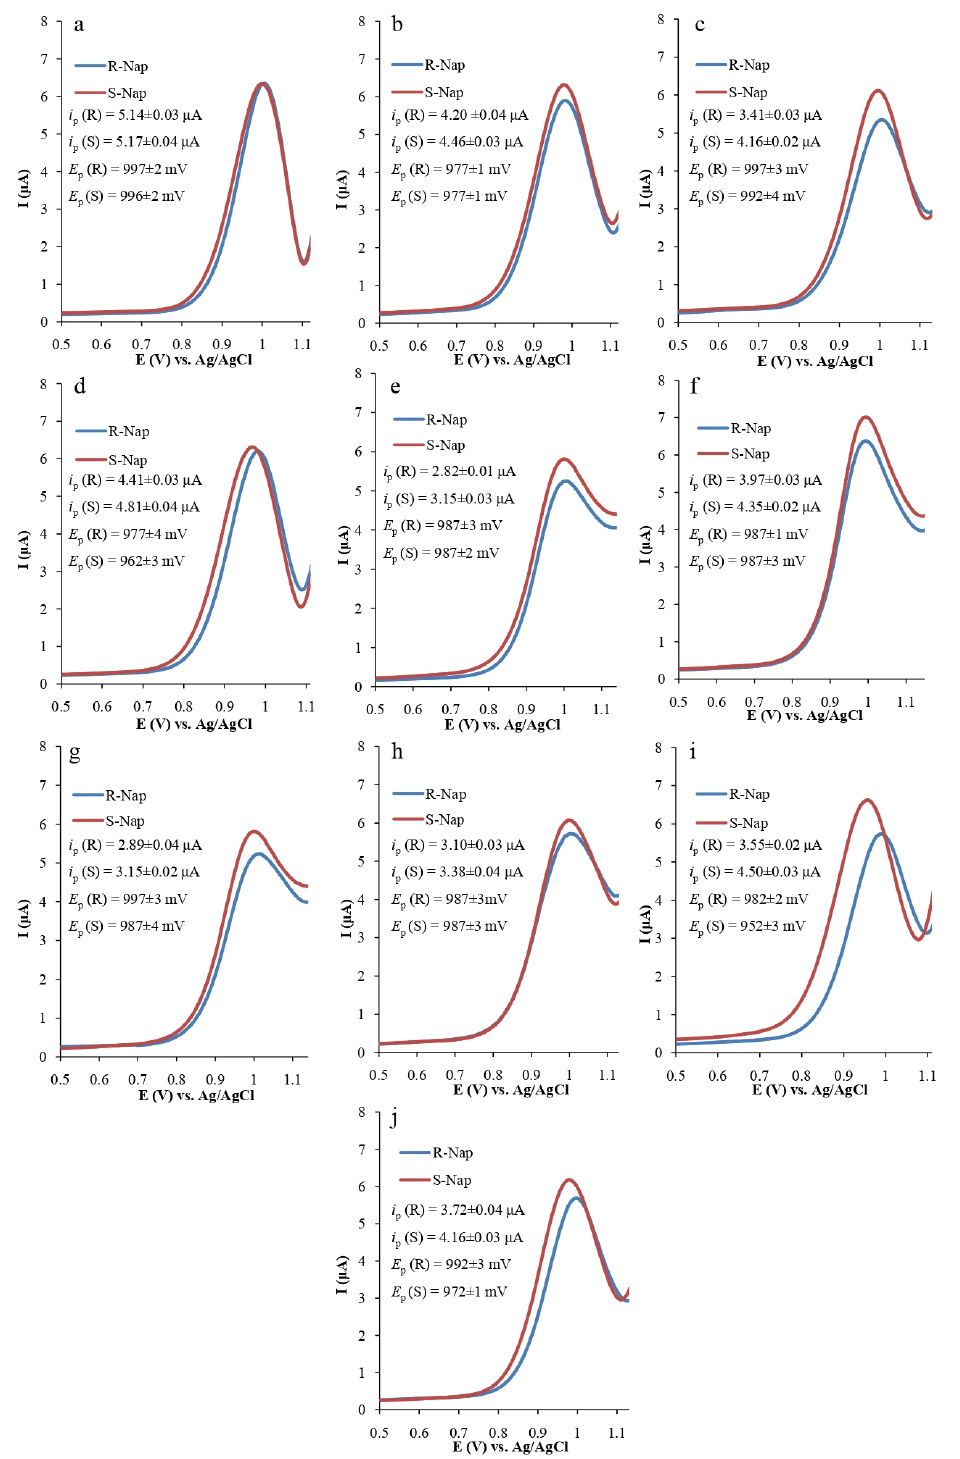
Figure 3. DPV of 1 mM solutions of R- and S-Nap on ( a ) GCE, ( b ) GCE/PEC, ( c ) GCE/PEC–( S